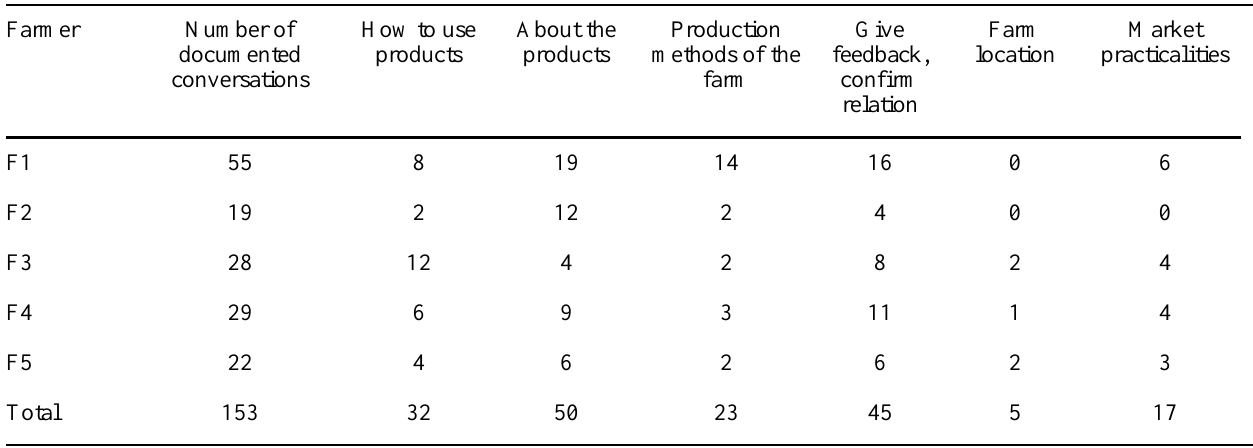
Farmer Number of